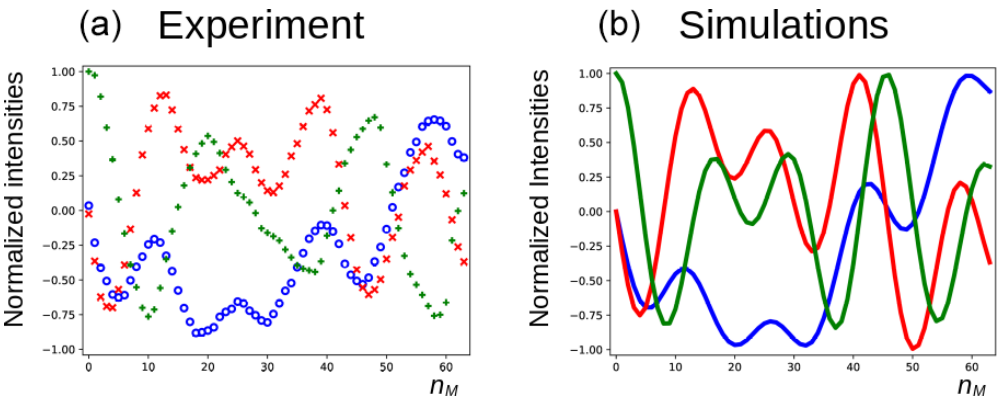
Figure 6. Same as Fig. 5 but with the carrier frequency set on H 2 O (conditions before mixing as in Fig. 2e); the same symbols as in Fig. 5 correspond to the same components of the magnetization. The RD parameters for the simulations in panel (b) were the same as in Fig.